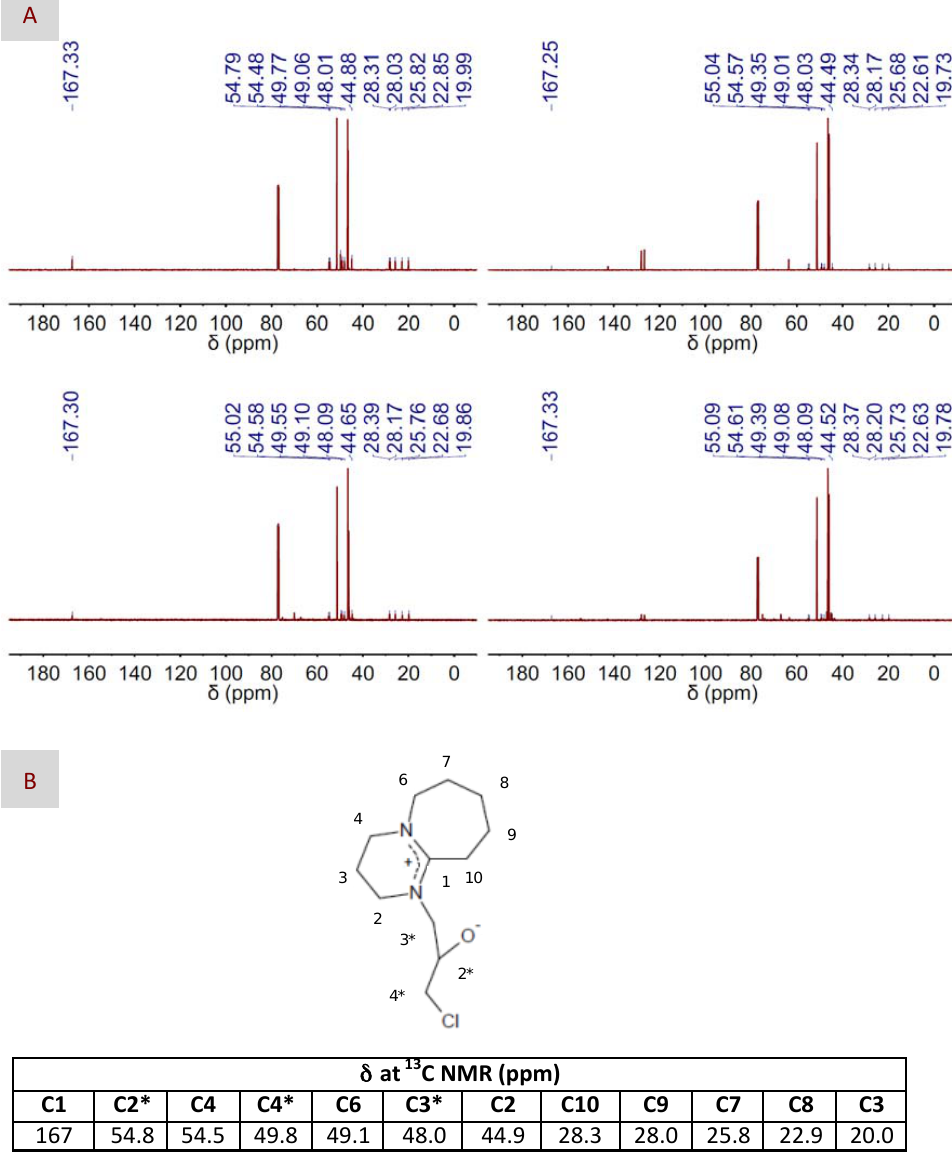
Figure 6. ( A ) 13 C NMR spectra of the intermediate observed in the reaction mixture composed of EP and DBU, in either its bare (left column) or DES-form (right column), and in the absence (top panel) or the presence (bottom panel) of CO 2 ; ( B ) The chemical structure proposed for the intermediate, as well as the chemical shifts assigned to the structure in the 13 C NMR spectra are also included for better visualization of the corresponding peaks at the NMR